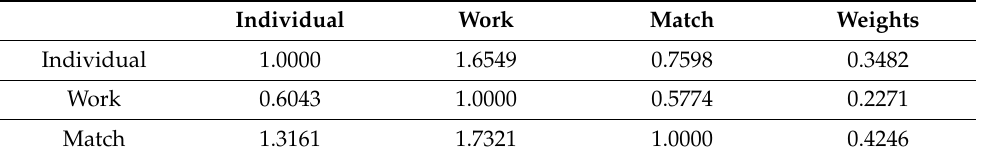
Table 2. Pairwise comparison matrix between the dimensions.